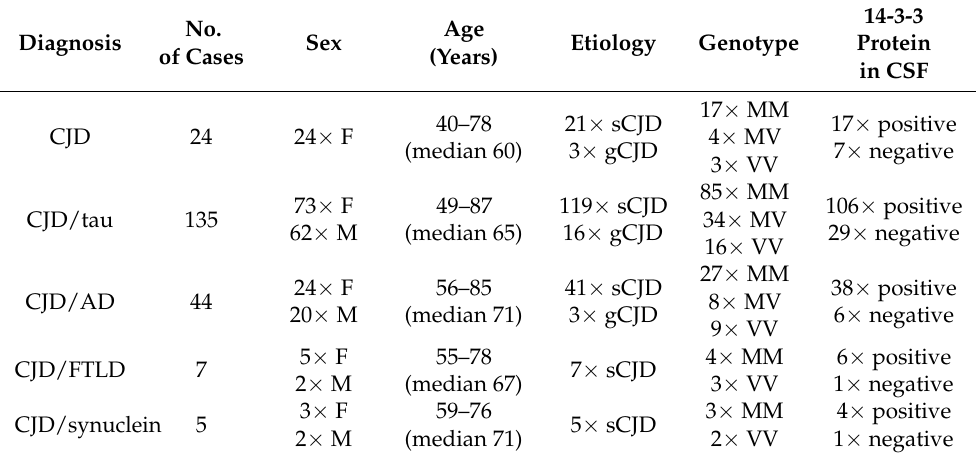
Table 1. Summary of available epidemiological, neuropathological, immunological and genetic data in non-comorbid vs. comorbid CJD cases. The first column shows the neuropathological diagnosis of patients, second shows the total number of cases in each group, third indicate the gender distribution (female/male). In the fourth column is age range with median age (in years) and the last two columns show methionine/valine polymorphism and presence of 14-3-3 protein in cerebrospinal fluid examinated by western